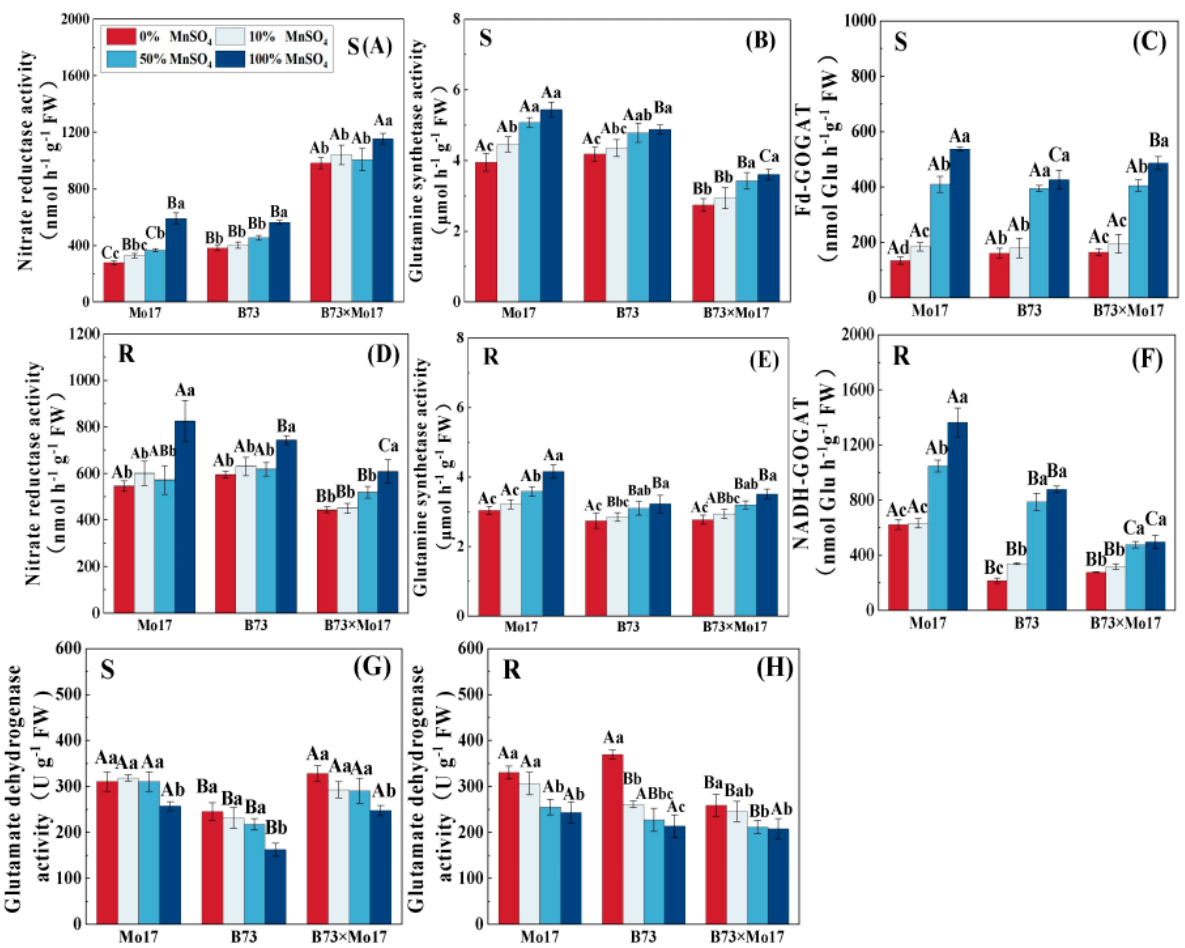
Figure 7. Effect of Mn deficiency on the activities of enzymes in nitrogen metabolism of maize seed-lings. Nitrate reductase activity ( A , D ), glutamine synthetase activity ( B , E ), Fd-GOGAT ( C , F ), gluta-mate dehydrogenase activity ( G , H ). According to the LSD test different capital letters: significant difference between varieties ( p < 0.05); different lowercase letters: significant difference between MnSO 4 treatments ( p < 0.05). S represents leaf-related parameters, R indicates root-related parame-ters.